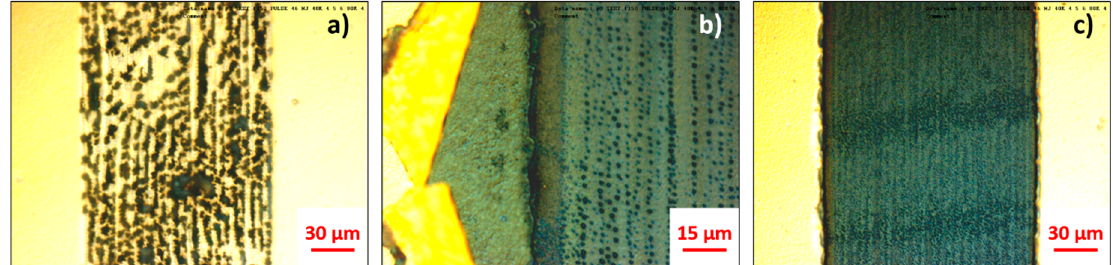
Figure 6. P3 laser ablation microscope analysis: ( a ) Optical image for a 130 µ m width P3 scribe obtained by using a RSD of 3 µ m and a pulse fluence value of 221.2 mJ · cm − 2 . In this case, the presence of electrical bridges between module constituting sub-cells due to an incomplete gold removal is clearly visible; ( b ) Optical image for a 130 µ m width P3 scribe obtained by using a RSD of 3 µ m and a pulse fluence value of 354 mJ · cm − 2 . In this case, the layer delamination on the edge of the ablated area is due to excessive stress experienced by the gold film during the P3 ablation; ( c ) Optical image for a 130 µ m width P3 scribe obtained by using a RSD of 3 µ m and a pulse fluence value of 306 mJ · cm − 2 . The as-optimized P3 ablation resulted in an ablated area with negligible gold residual flakes and sharp edges without layer delamination.